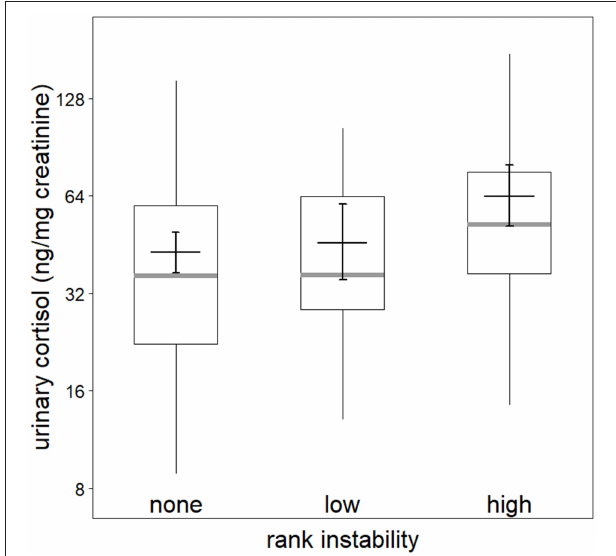
FIGURE 1 | Effect of rank instability on urinary cortisol levels (logarithmic scale). Indicated are the median (gray bar), the fitted model and its 95% confidence intervals (black bar and error bars; based on presence of potentially fertile females and group identity manually dummy coded and centered). Boxes indicate quartiles (25 and 75%) and vertical lines represent quantiles (2.5 and 97.5%).